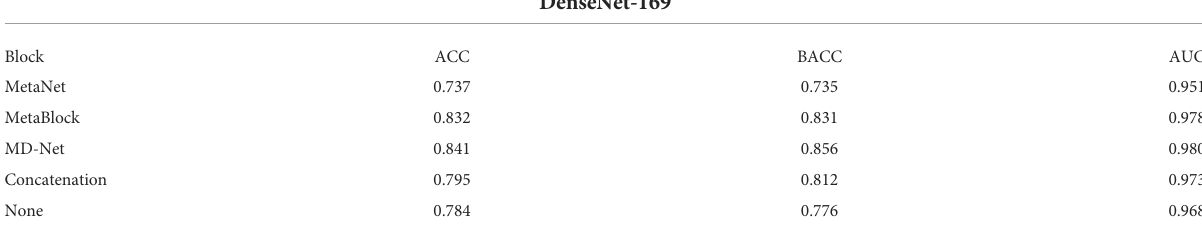
TABLE 10 Compare the performance of DenseNet-169 network fusing different modules on the ISIC 2019 dataset. HIGHEST AVERAGE BACC FOR EACH MODEL.